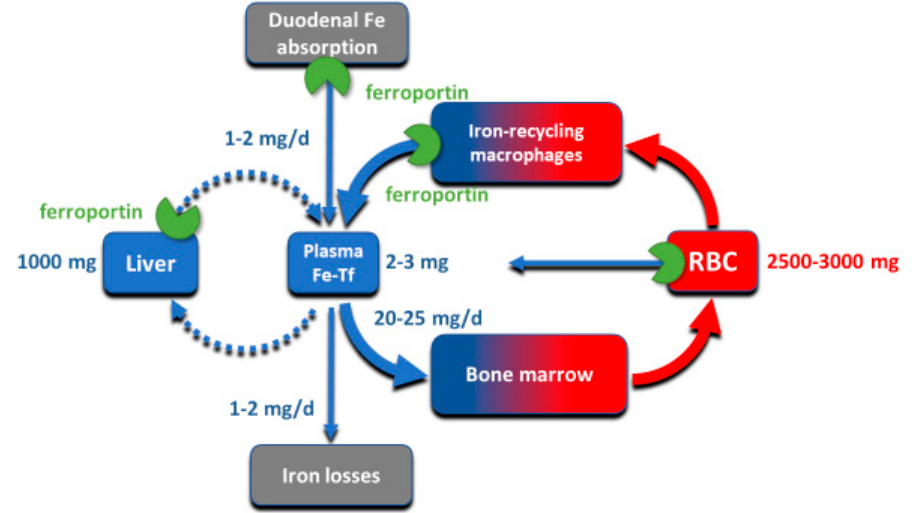
Figure 1. The key iron flows and compartments.